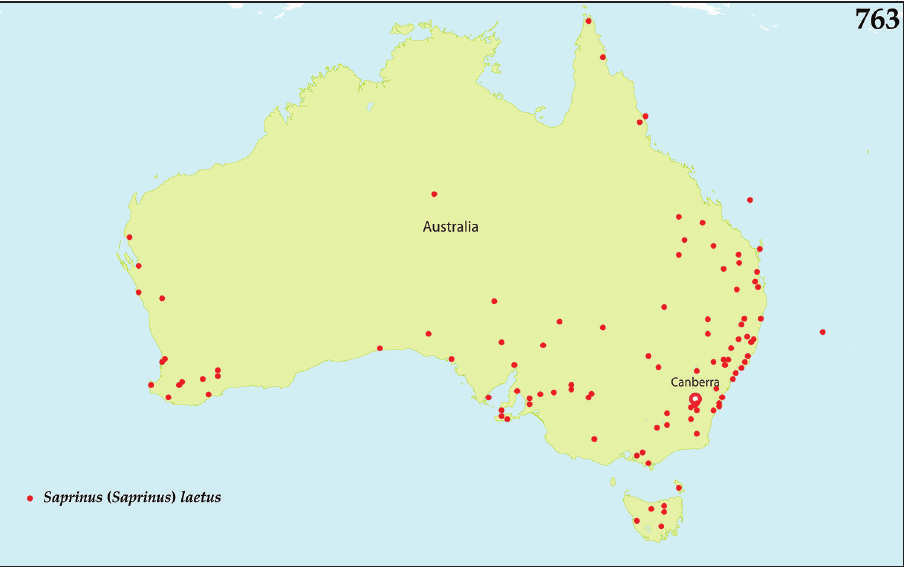
Figure 763. Distribution of Saprinus ( Saprinus ) laetus Erichson, 1834 in